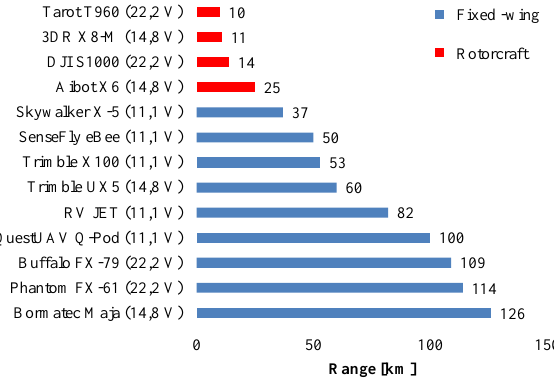
Figure 2 Range comparison. Adapted from (Trojanek, 2015)